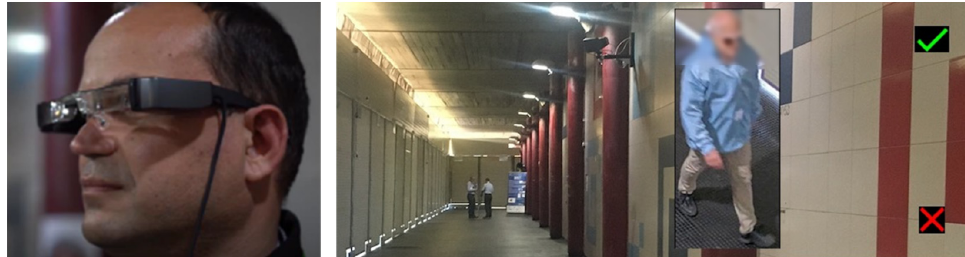
Figure 10. Detections are visualized on smart glasses ( left ). The person related to the weapon